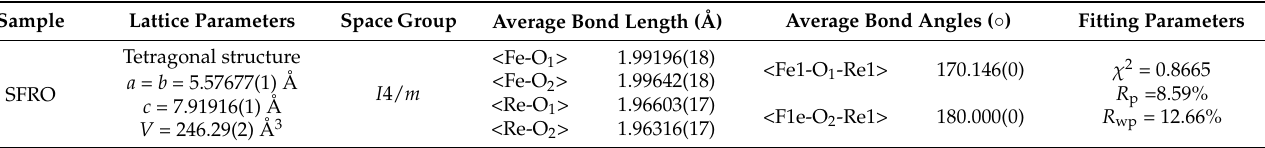
Figure 2. Rietveld refinements on the XRD data of the SFRO powders (sample B) annealed at 1100 °C under N 2 atmosphere. Black cross symbols present the experimental data, the red solid line indicates the simulated XRD profile, and the tick marks represent the positions of the allowed Bragg reflections. The bottom continuous blue line stands for the difference between the experimental and theoretical patterns. Table 1. Refined lattice parameters, selected bond length and bond angles, and the fitting parameters of the SFRO powders annealed at 1100 ◦ C under N 2